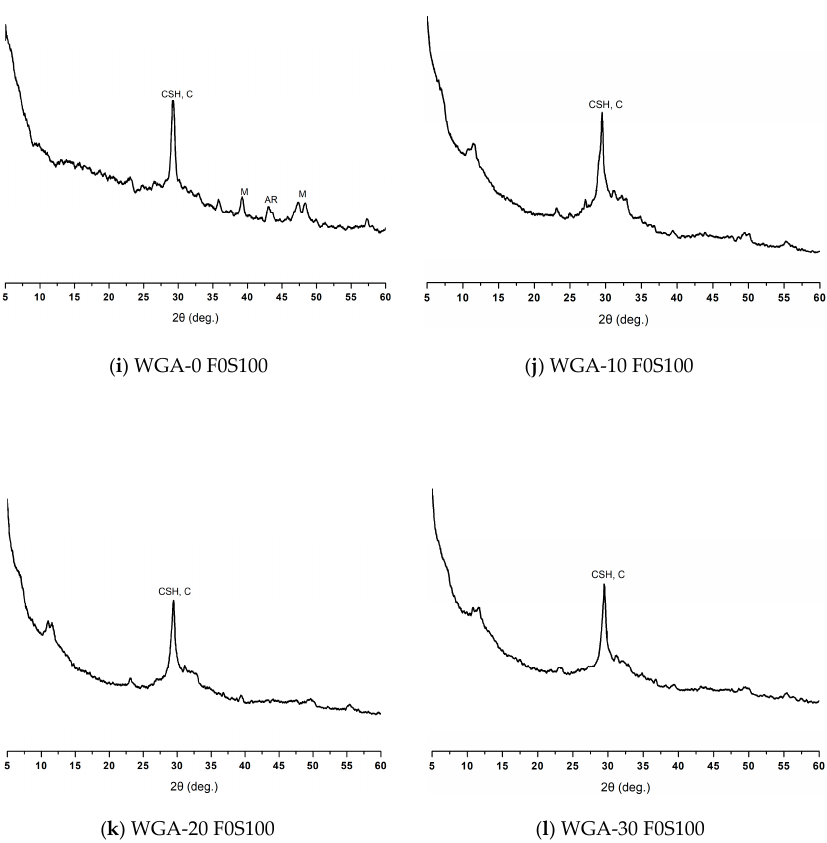
Figure 10. XRD diffraction pattern of; ( a ) WGA-0 F100S0, ( b ) WGA-10 F100S0, ( c ) WGA-20 F100S0, Figure 10. XRD di ff raction pattern of; ( a ) WGA-0 F100S0, ( b ) WGA-10 F100S0, ( c ) WGA-20